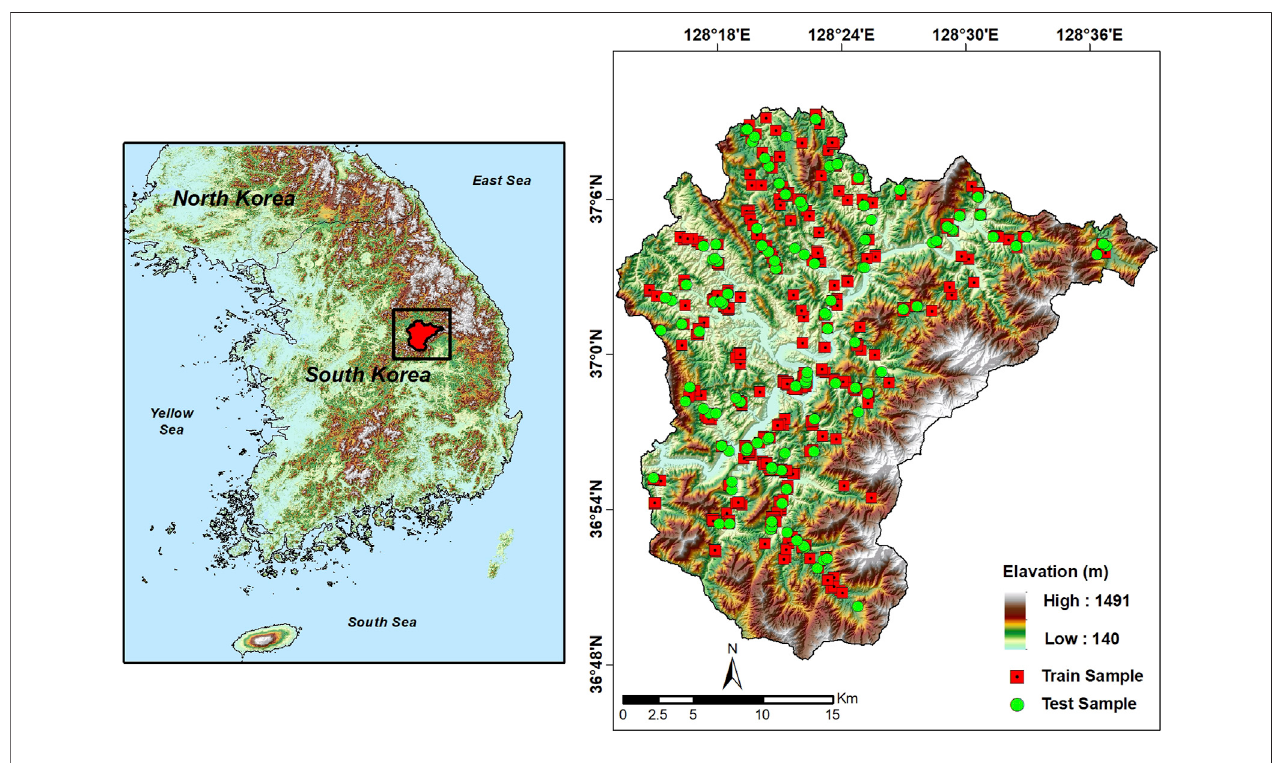
FIGURE 1 | Map of the study area showing radon monitoring